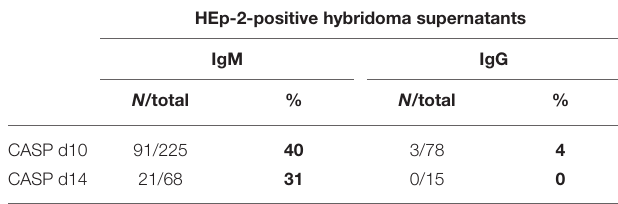
TABLE 2 | HEp-2-positive IgM- or IgG-secreting hybridomas.